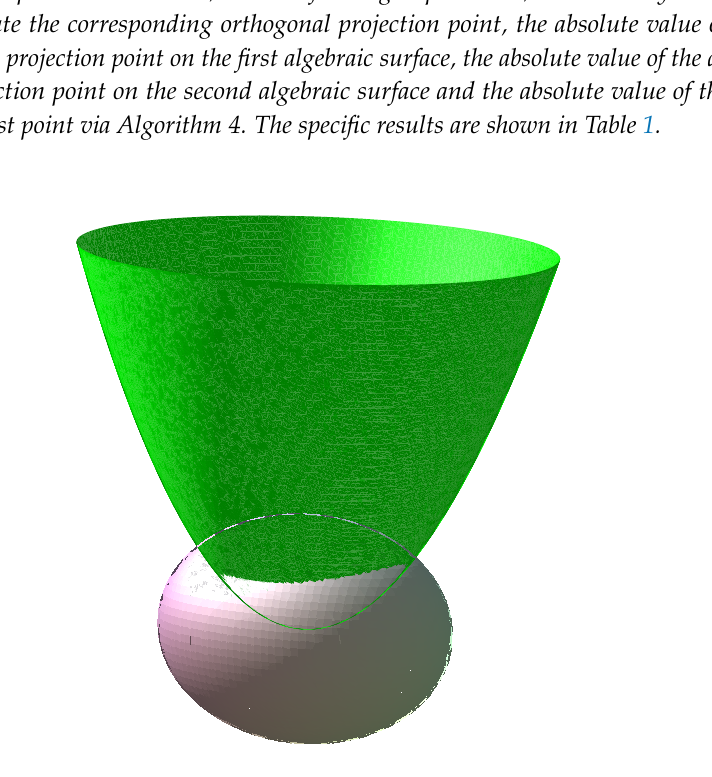
Figure 6. Graphical representation of the spatial algebraic curve for Example